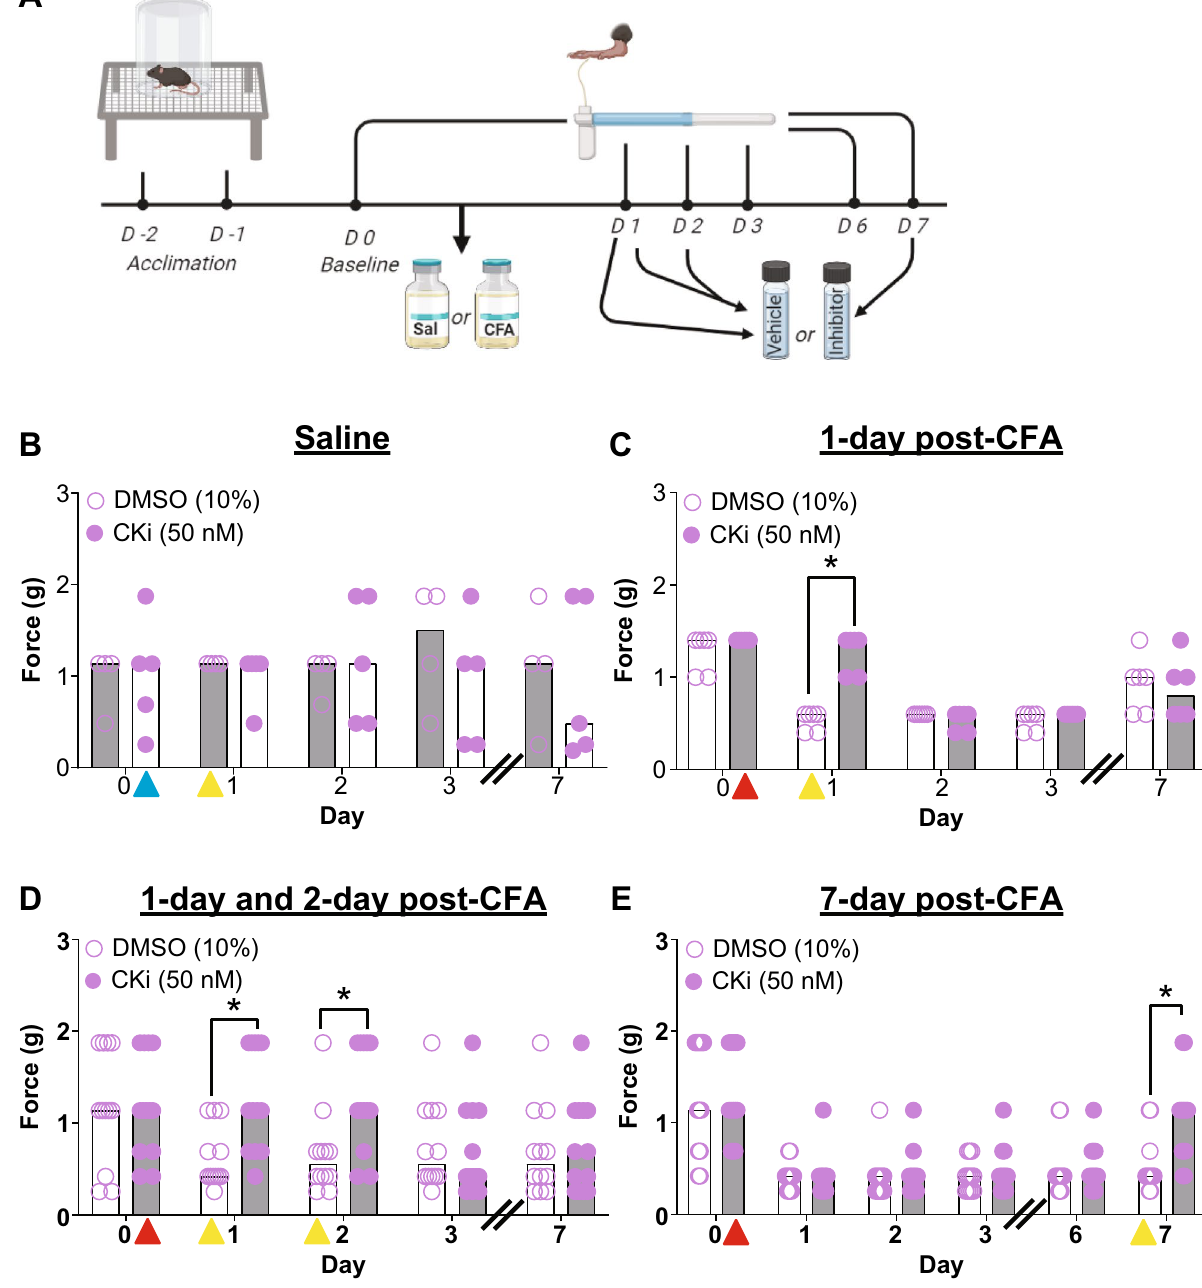
Figure 3. Cathepsin K inhibitor (50 nM) reduces mechanical hypersensitivity in mice. ( A ) Timeline for testing mechanical hypersensitivity. ( B ) There is no effect of the 50 nM cKi when given in mice with saline injection. Blue and yellow triangle indicates the time of saline and cKi injection respectively. ( C ) Whereas a single injection of 50 nM cKi (yellow triangle) when given before testing on day 1 post-CFA (complete Freund’s adjuvant) injection (red triangle) results in higher mechanical threshold as compared to vehicle (10% DMSO in saline) injection. ( D ) During the developmental phase of chronic inflammatory pain (i.e., on day 1 and day 2 post-CFA injection), subsequent injections of 50 nM cKi can alleviate hypersensitivity compared to vehicle injection. ( E ) Similarly, during the maintenance phase of persistent inflammatory pain (i.e., on day 7 post- CFA injection) 50 nM cKi injection reduces mechanical hypersensitivity when compared to vehicle injection. Data are represented at scatter plots of individual mice with bar graphs overlayed indicating the median value. *p < 0.05 Mann–Whitney test between cKi and vehicle treatment for each